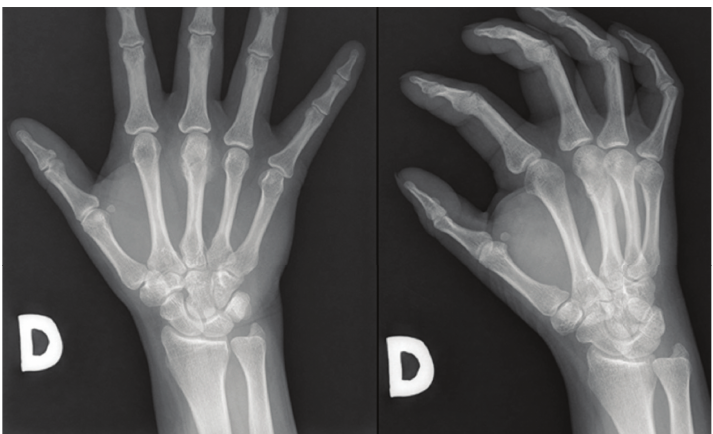
Figure 1: Plain radiograph of the right hand showing a dense mass extending from the dorsal aspect of the third distal metacarpal.